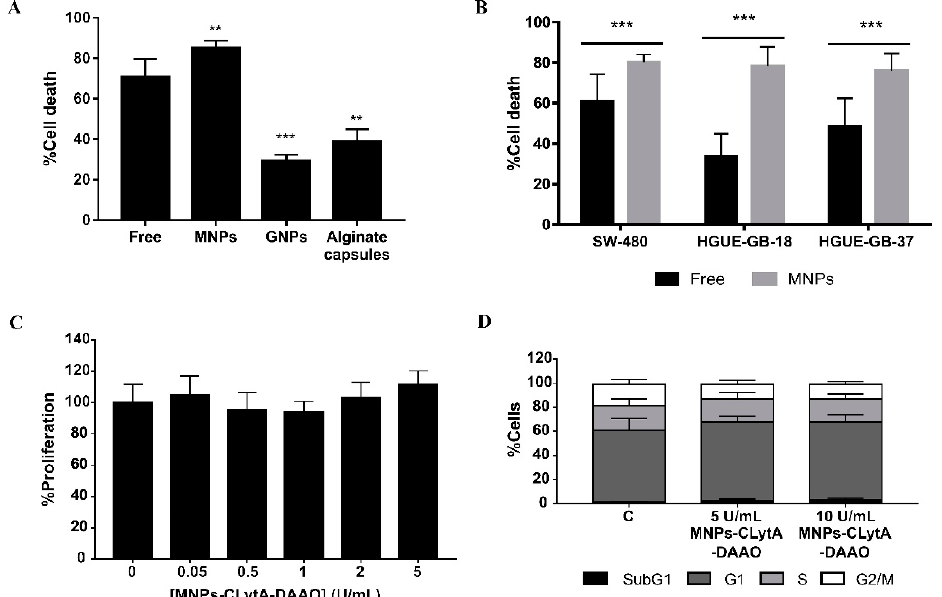
Figure 1. Cell death induced by CLytA-DAAO free, immobilized in magnetic nanoparticles (MNPs), in gold nanoparticles (GNPs), and immobilized in alginate capsules. ( A ) IMIM-PC-2 pancreatic carcinoma cell line was treated with 2 U/mL CLytA-DAAO, free or immobilized in MNPs, GNPs or alginate capsules, and 1 mM D-Ala for 24 h. ( B ) SW-480 colorectal carcinoma cell line and HGUE-GB-18 and HGUE-GB-37 glioblastoma cell lines were treated with 2 U/mL CLytA-DAAO, free or immobilized in MNPs, and 1 mM D-Ala for 24 h. Cell viability was determined using Muse cell analyzer. Graphs represent cell death percentage (mean ± SD) after subtracting cell death in the control untreated ( n ≥ 3). ( C ) IMIM-PC-2 cell line was treated with CLytA-DAAO bound to MNPs in a concentration range between 0.05–5 U/mL for 72 h. Graph shows the proliferation percentage ± SD normalized with respect to the control untreated ( n ≥ 6). ( D ) IMIM-PC-2 cell line was treated with 5 or 10 U/mL CLytA-DAAO immobilized in magnetic nanoparticles for 24 h and the cell distribution in each phase of cell cycle was determined by flow cytometry. Graph shows the cell percentage in each phase of cell cycle (mean ± SD) ( n ≥ 3). ** Indicates a p -value < 0.01 and *** p -value < 0.001.